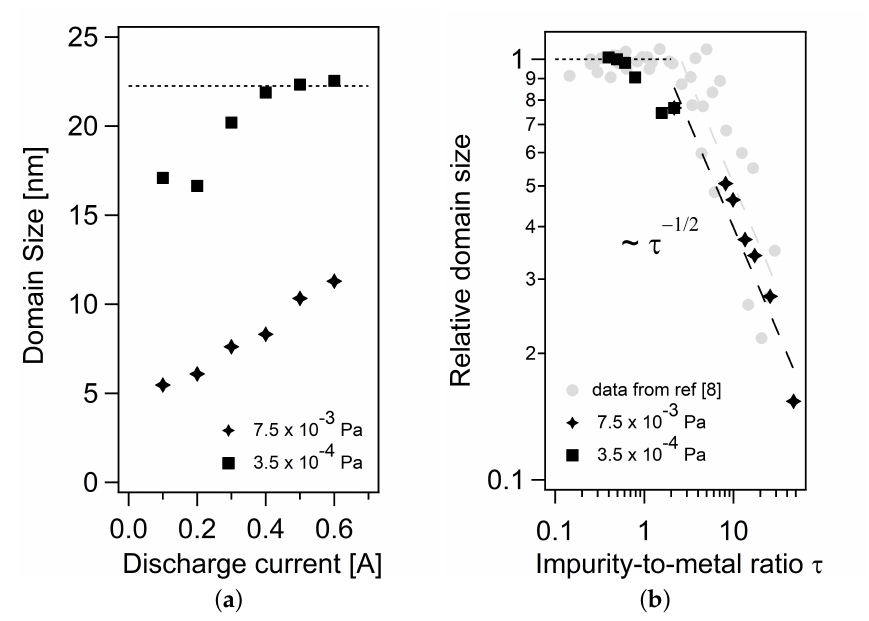
Figure 4. ( a ) Domain size as function of the discharge current; ( b ) Domain size presented as function of the impurity-to-metal impingement flux ratio. The square markers represent the deposition performed at low background pressure (3.50 × 10 − 4 Pa), the diamond markers represents the depositions performed at high background pressure (7.50 × 10 − 3 Pa). The dotted lines in the figures represents the average domain size in the low-impurity regime. The striped lines ( b ) represent the relation D ∼ τ − 1/2 .